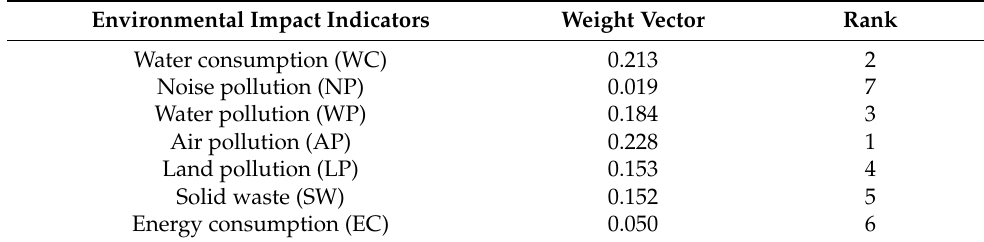
Table 7. The rank of the